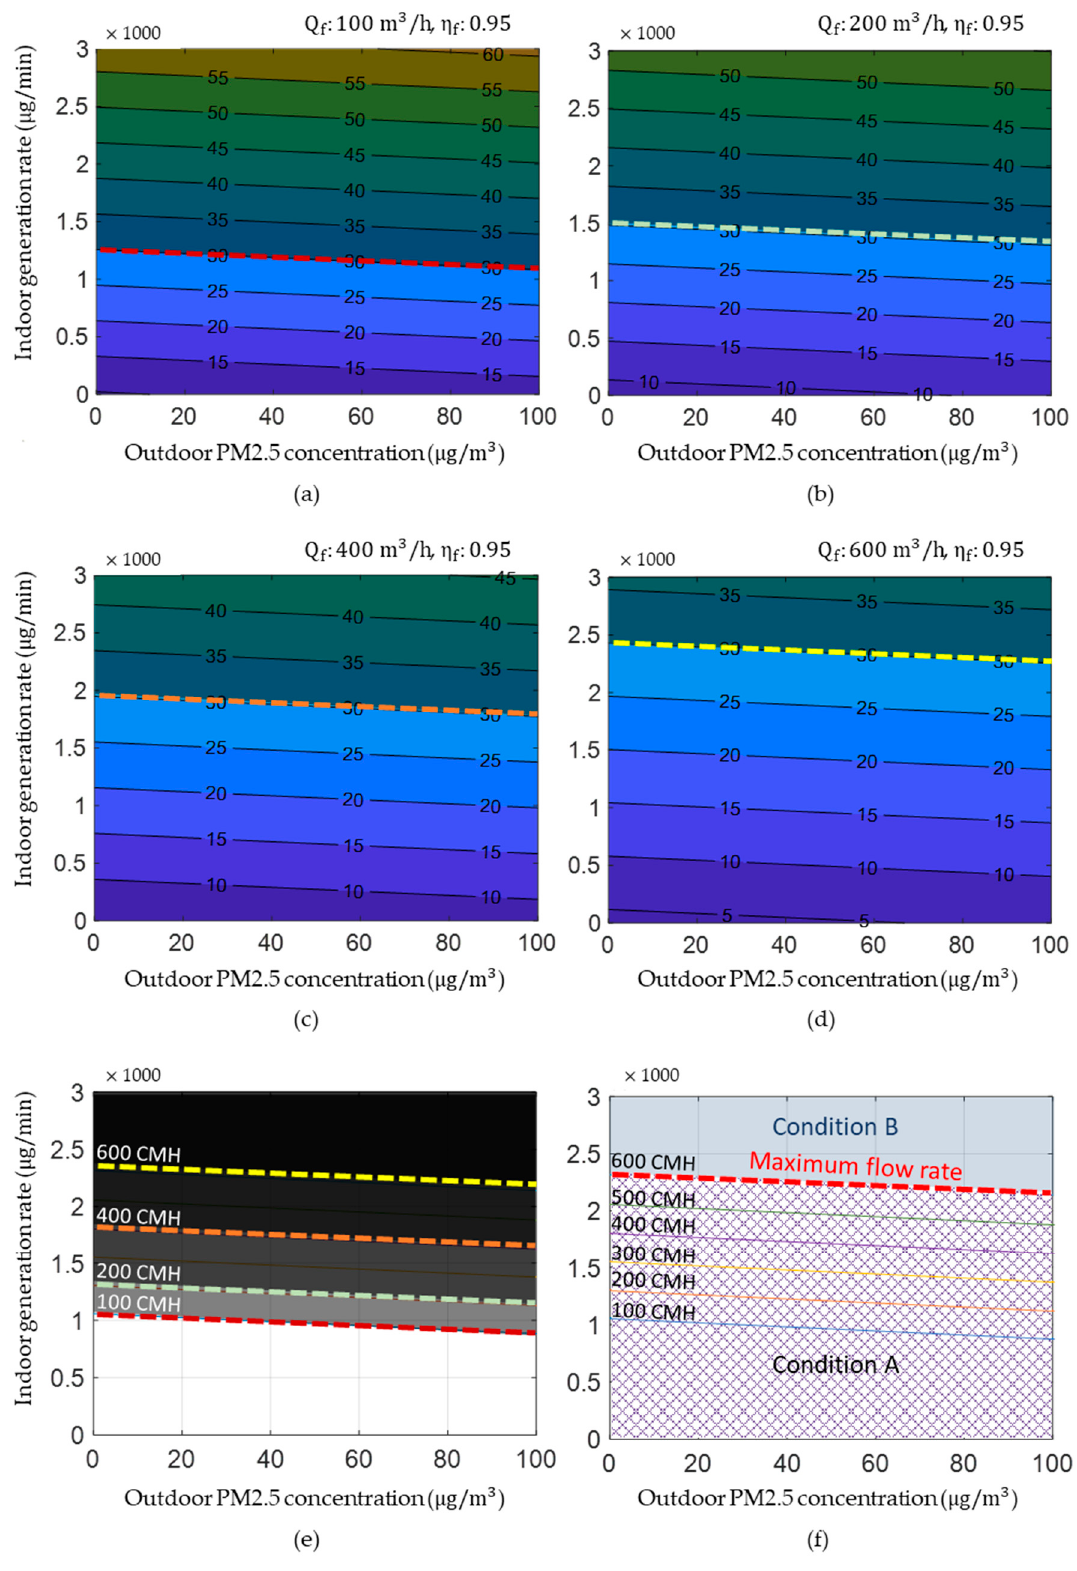
Figure 7. ( a – d ) Indoor particle concentration characteristics depending on the filtration rates when the filter efficiency of system is 0.95; ( e ) filtration control limit graphs to maintain the target indoor PM that vary with filtration flow rates; and ( f ) indoor and outdoor particle conditions separated by the maximum flow filtration control limit.